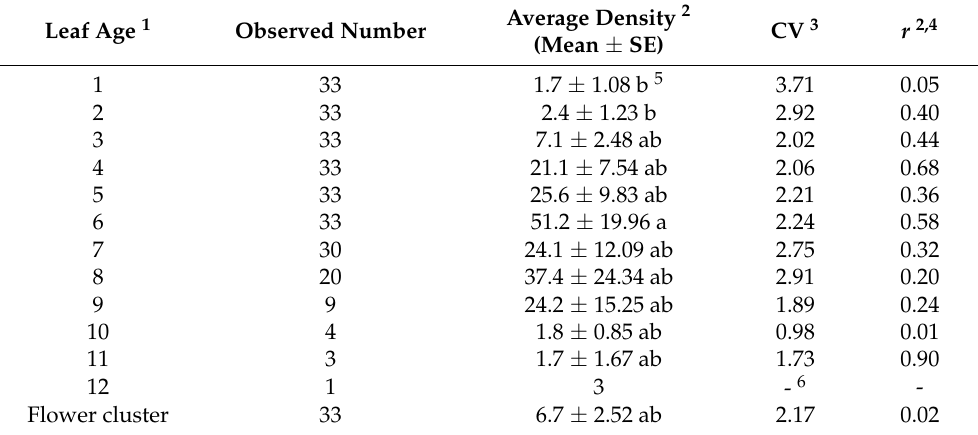
Table 3. Observed plant number, average density, coefficient of variation (CV), and coefficient of determination ( r 2 ) of T. urticae motiles according to leaf age within a strawberry plant in the second farm.